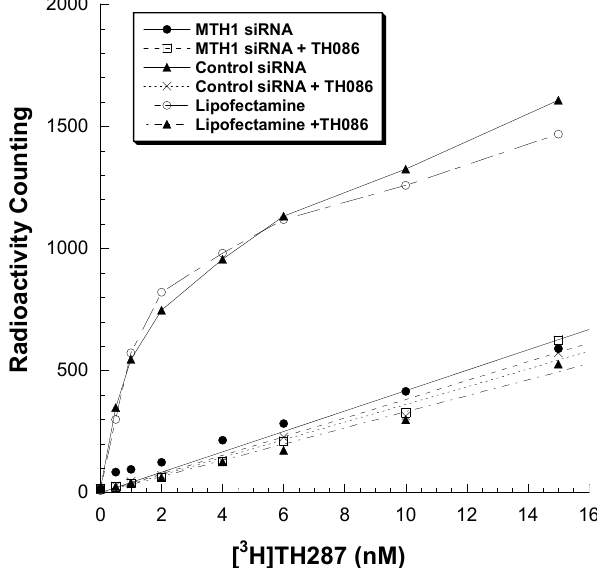
Figure 3. Saturation binding assay for [ 3 H]TH287 to the MTH1 in MTH1 knockdown glioblastoma cells (U251MG). Representative saturation binding experiments which show the binding of [ 3 H]TH287 in control groups and MTH1 knockdown groups. n = 3, samples in triplicate.